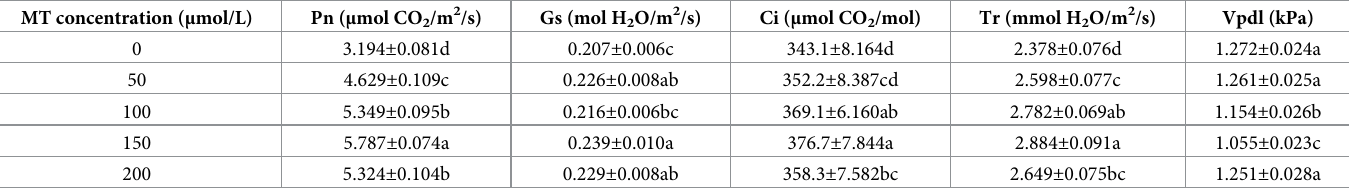
Table 2. Photosynthetic parameters of grape seedlings.